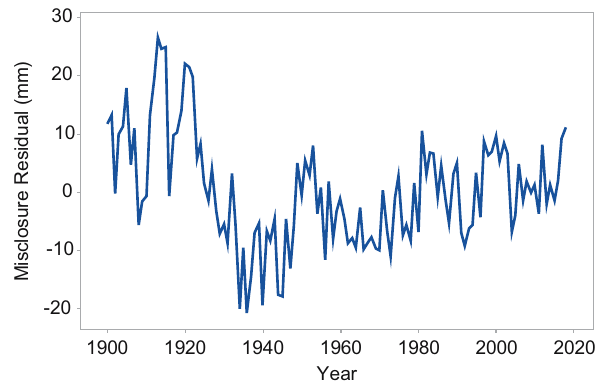
Figure 9: Misclosure residuals ( mm ) of the WLS solution to the trend - only